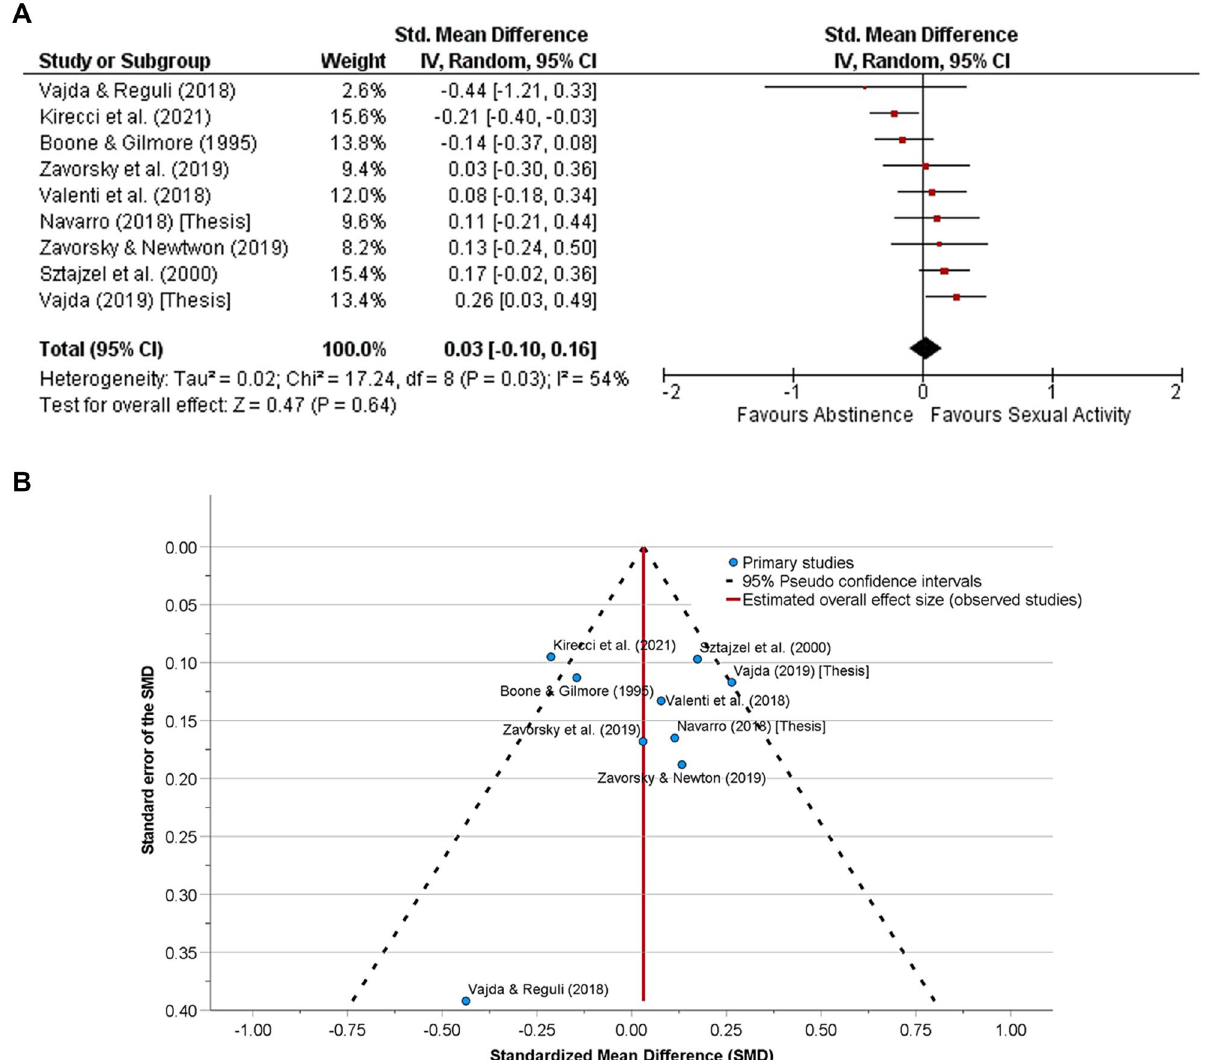
Figure 4. (A) The effect of sexual activity that occurred 30 min to 24 h before any type of physical fitness assessment (aerobic, musculoskeletal endurance, and strength/power) are summarized in this Forest Plot. There were three outcomes for Zavorsky and Newton 44 (n = 10), four outcomes for Zavorsky et al . 45 (n = 7), three outcomes for Vajda and Rejuli 51 (n = 2), two outcomes for Valenti et al. 52 (n = 12), and two outcomes for Navarro 43 (n = 10); thus, the average standardized mean difference (SMD) and standard error of the SMD was used for each study with multiple outcomes in this plot. The remaining studies had one outcome. The data demonstrate that any physical performance measure is unlikely affected by either prior sexual activity or abstinence ( p = 0.64). That is, both experimental and control conditions provide similar test results. No other adjustments were made here. There was substantial heterogeneity between studies ( p = 0.03). ( B) Funnel plot for the detection of publication bias in ( A ). Egger’s random effects meta-regression-based test was used with the Knapp-Hartung SE adjustment. There was no funnel plot asymmetry (Intercept = 0.10, SE = 0.19, t = 0.55, p = 0.60, 95% CI of the coefficient = − 0.34 to 0.55); Standard error of the effect size = − 0.55, SE = 1.34, t = − 0.41, p = 0.70, 95% CI − 3.71 to 2.62). After adjusting for the missing studies, the SMD (SE of the SMD) was similar